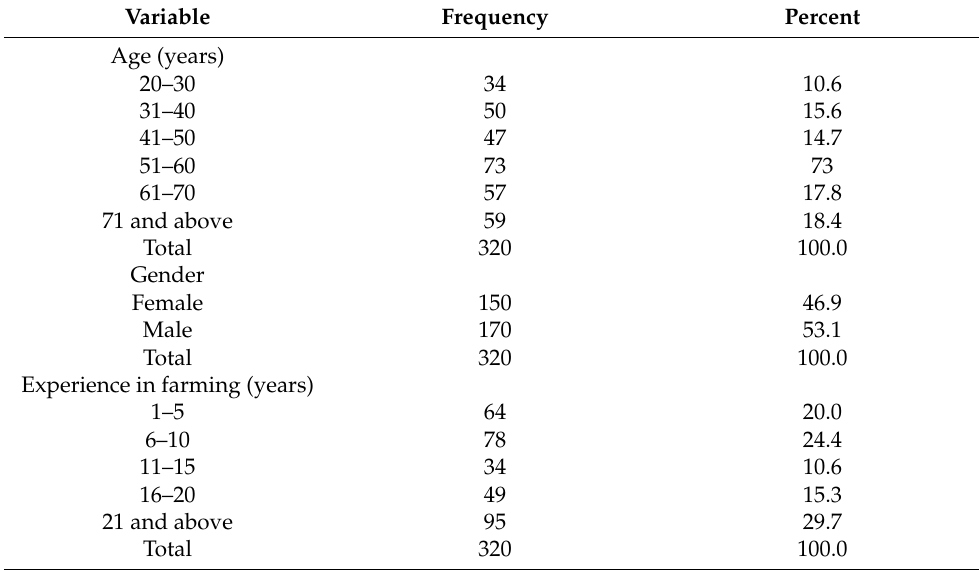
Table 2. Demographic characteristics of smallholder farmers (n = 320).